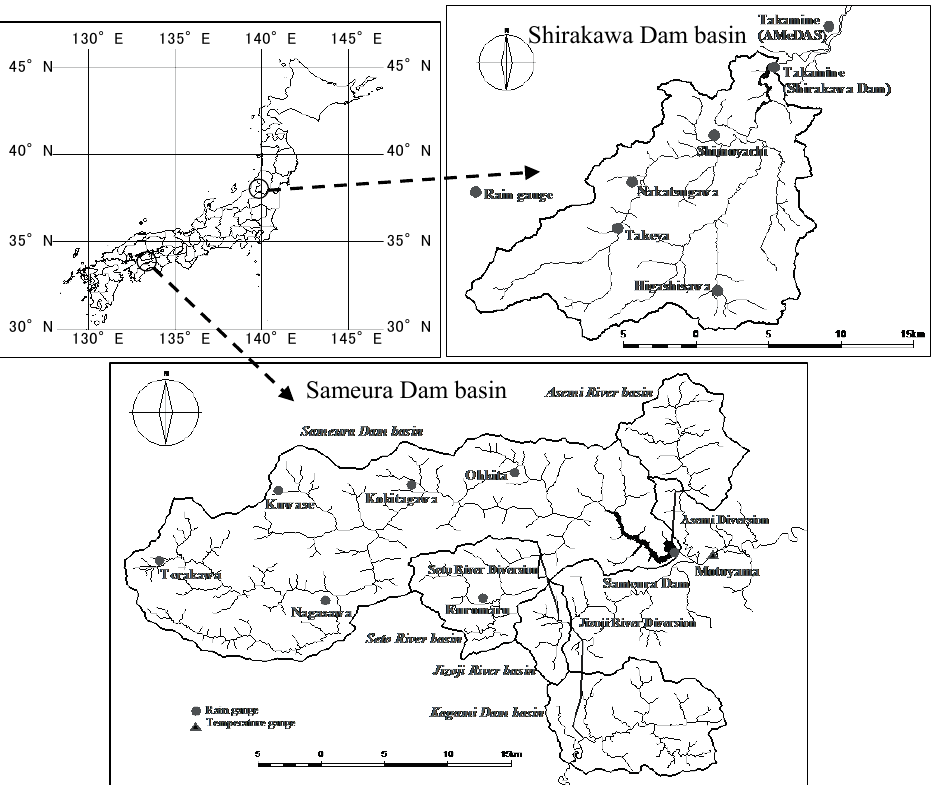
Fig. 1 Maps of the Sameura Dam basin (SAME basin) in the Shikoku region and the Shirakawa Dam basin (SIRA basin) in the Tohoku